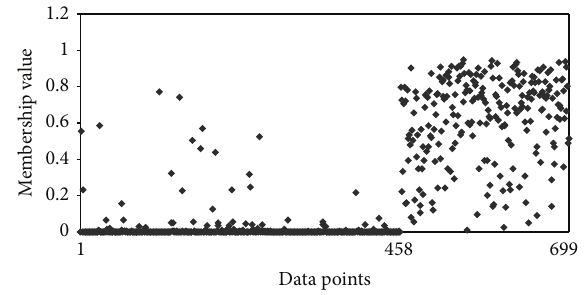
for malignant cluster. This suggests that with Hamming distance membership values of benign data points are low; however, membership values of malignant data points are not as high as that with the proposed algorithm. These observations demonstrate that, with the distance measure proposed by Ahmad and Dey [22], better membership values were